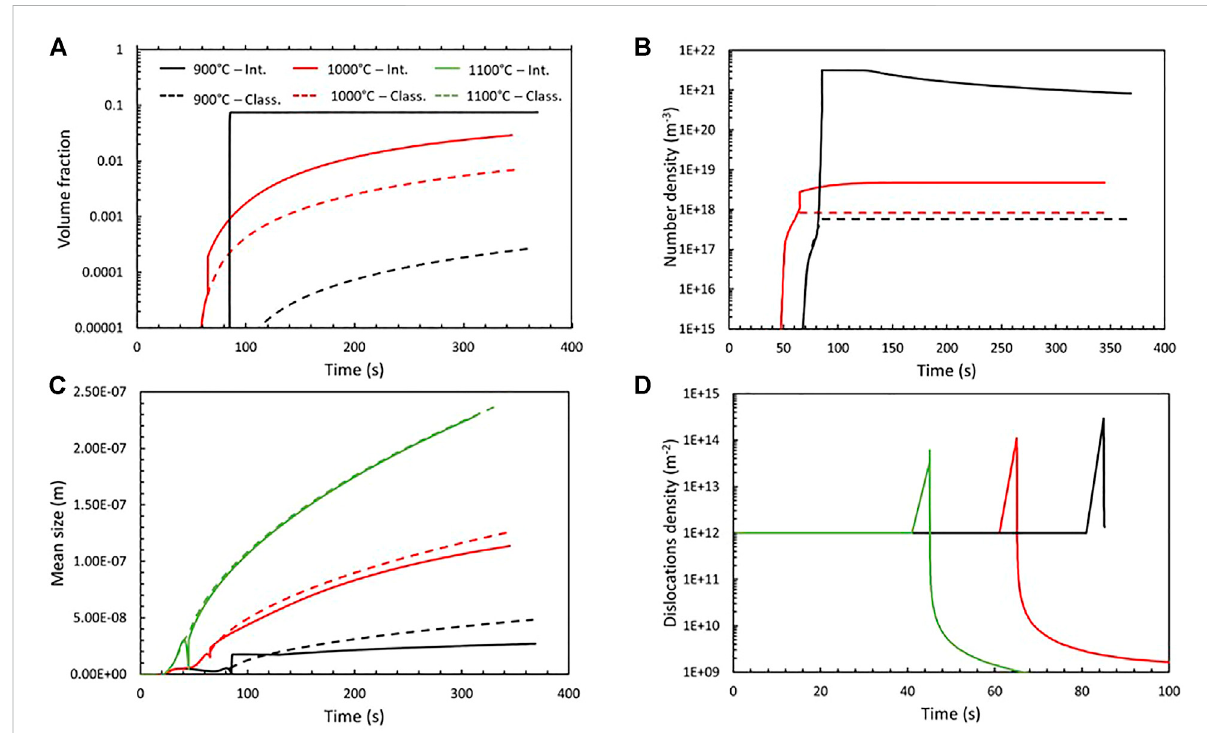
FIGURE 3 Evolution of volume fraction (A) , number density (B) , mean size (C) of M 7 C 3 precipitates, and dislocation density (D) as a function of time for holding at 900 ° C (black), 1,000 ° C (red), and 1,100 ° C (green) using the integrated modeling tool (plain lines) and the classical precipitation model (dashed